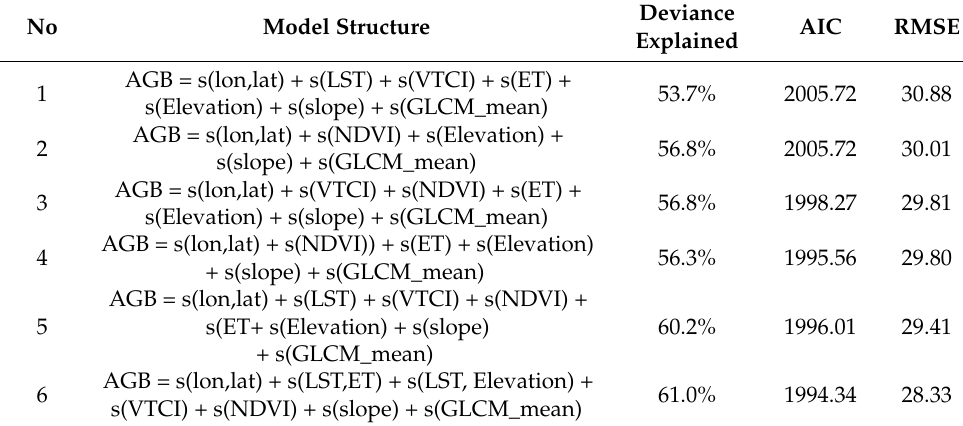
Table 9. Analysis of deviation in a forward selection regression process in six above-ground biomass (AGB)